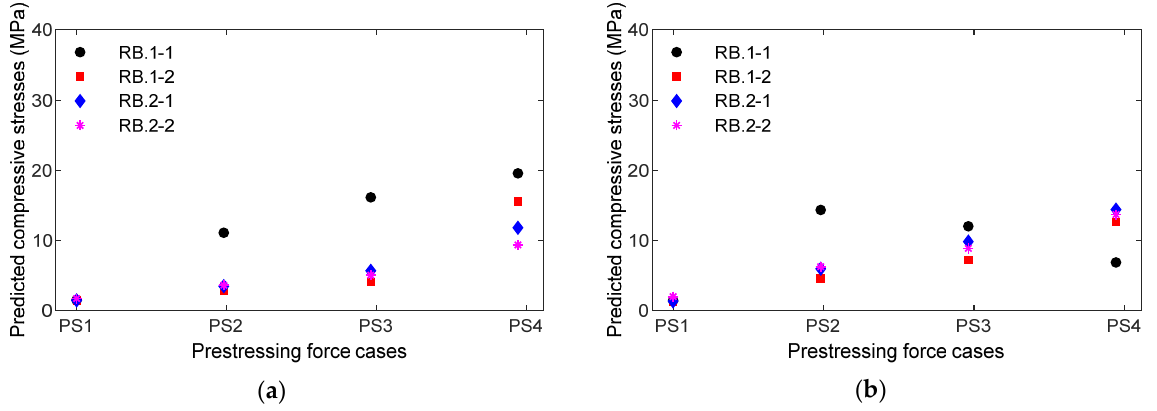
Figure 25. Predicted compressive stresses via measured impedance signatures for loading cases PS1~PS4: four smart rebars RB.1-1~RB.2-2: ( a ) FEM estimation using the empirical equation; ( b ) Experiment prediction.